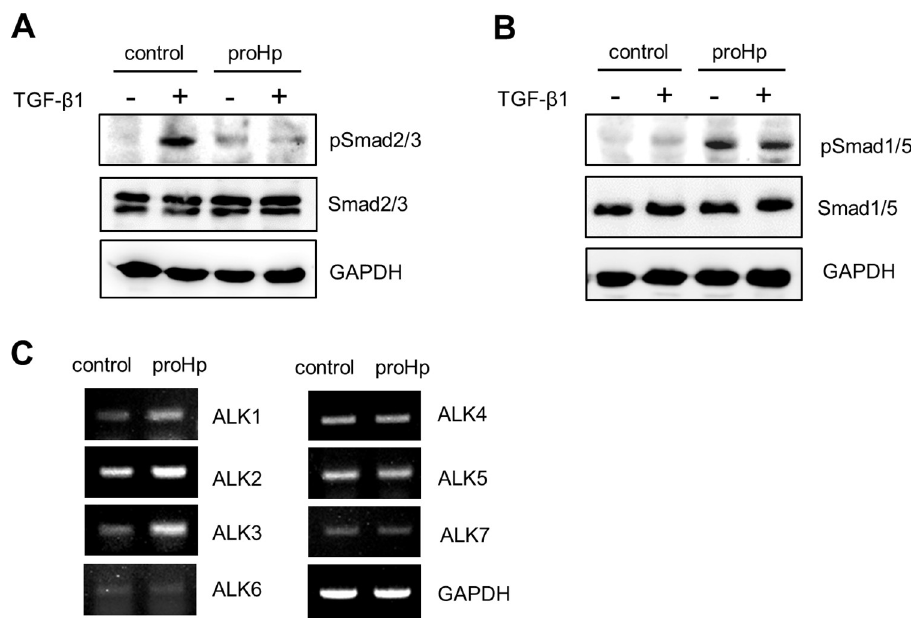
Fig 4. proHp inhibits TGF- β -induced Smad2/3 phosphorylation and increases expression of ALK1/2/3 receptors in SK-Hep1 cells. After transfection with vector DNA (control) or Hp gene (proHp), the cells were incubated for 24 h in DMEM containing 10% FBS. (A and B) For serum starvation, the cells were further incubated for 3 h in serum-free medium, and then 5ng/mL TGF- β was added into the culture medium. After treatment for 1 h, phosphorylation of Smad2/3 (pSmad2/3) and Smad1/5 (pSmad1/5) in cell lysates was detected by Western blot analysis. (C) mRNA levels of TGF- β type I receptors (ALK1 to ALK7) in control and proHp-overexpressing cells were determined by RT-PCR. All experiments were performed at least twice with similar results, and representative data are